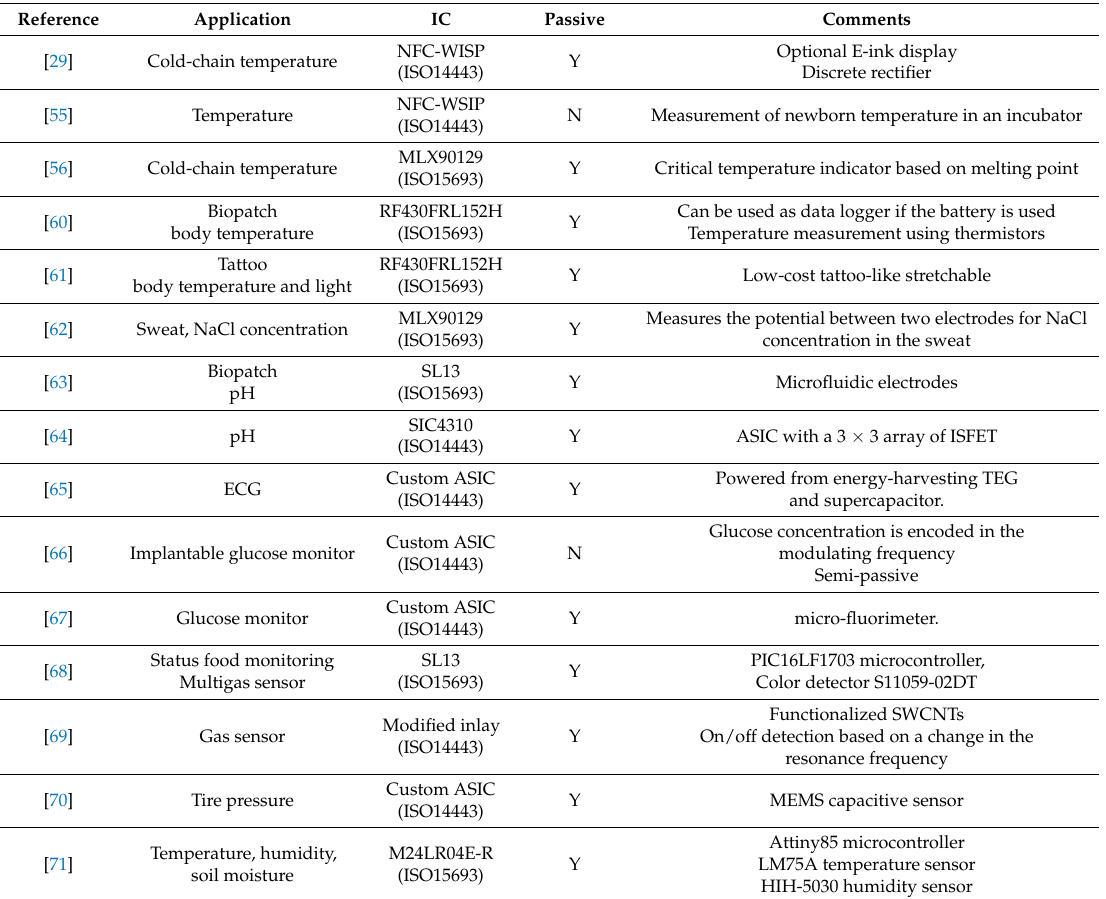
Table 5. Comparison of NFC-based sensors in the literature. Y—yes; N—no; ASIC— application-specific integrated circuit; ISFET—ion-sensitive field-effect transistor;